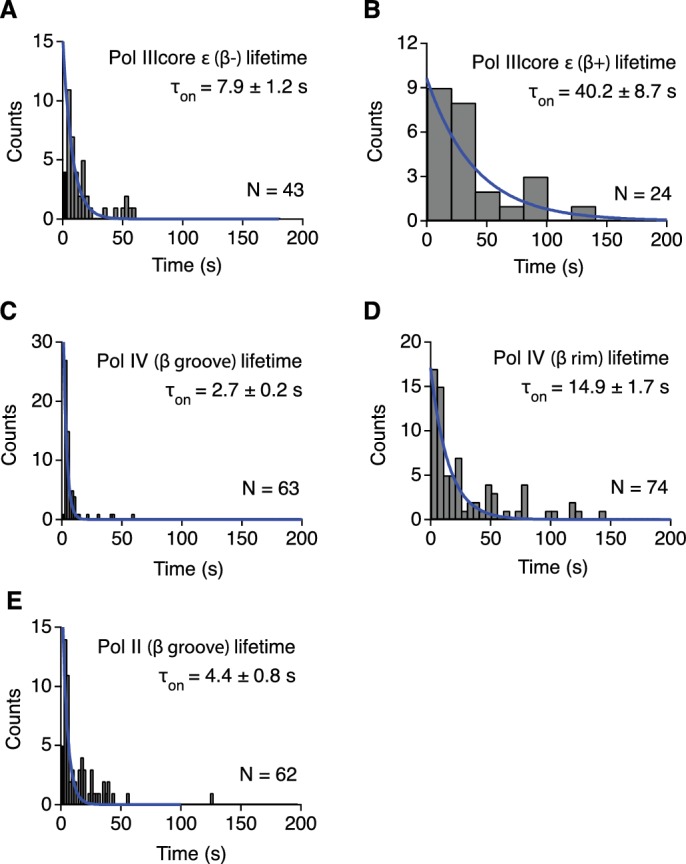
Lifetimes of β-clamp binding mutants of Pol IIIcore, Pol IV and Pol II.(A) Lifetime of Pol IIIcore with a reduced β-binding motif in the ε subunit. (B) Lifetime of Pol IIIcore with an improved β-binding motif in the ε subunit. (C) Lifetime of Pol IV with a mutated β-groove binding motif. (D) Lifetime of Pol IV with a mutated β-rim binding motif. (E) Lifetime of Pol II with a mutated β-groove binding motif. All values represent mean lifetime ±s.e.m.